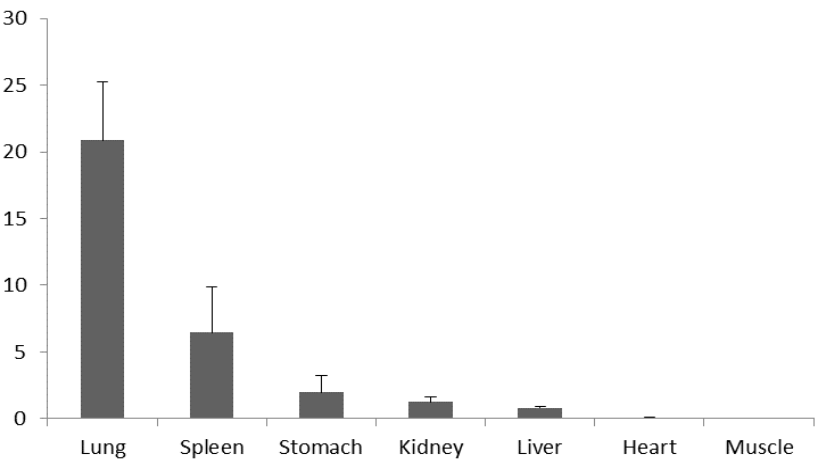
Figure 1. Relative quantification of total mRNA expression levels of porcine NK-lysin ( NKL ) gene in 7 tissues. Bars represent the Mean ± SEM (n = 3).